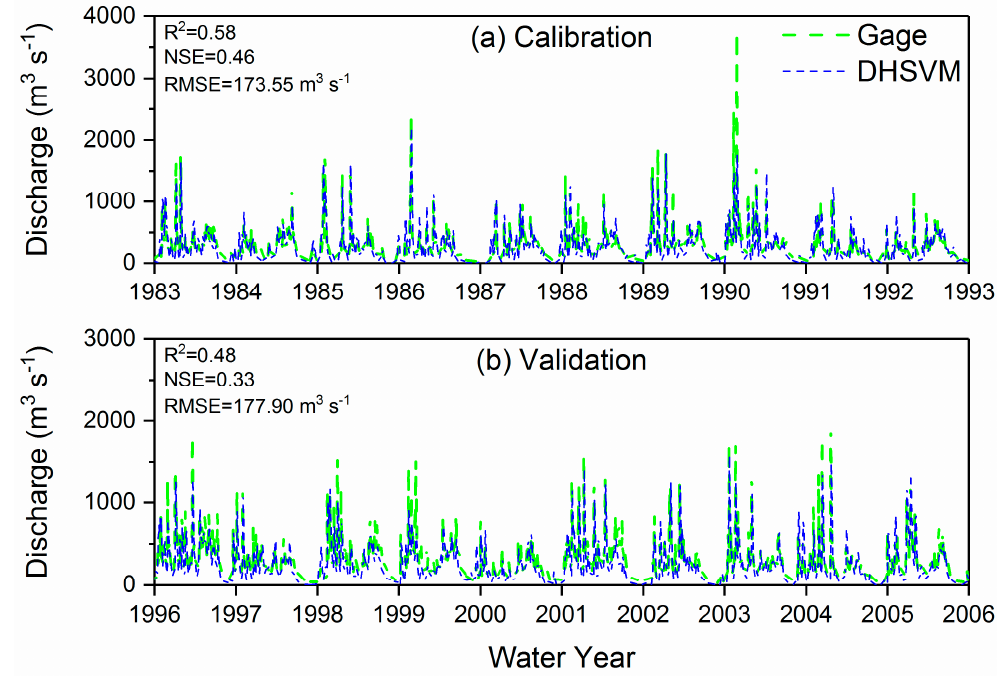
Figure 3. The DHSVM calibration and validation at Monroe, WA, USA. Table 2. The water years used for flow frequency analysis.